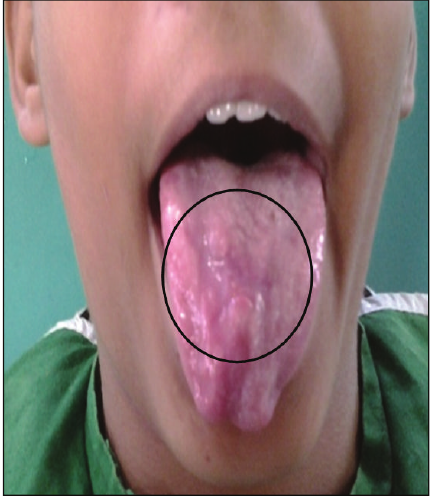
Figure 4: Complete healing of ulcer on tongue (after 30 days of